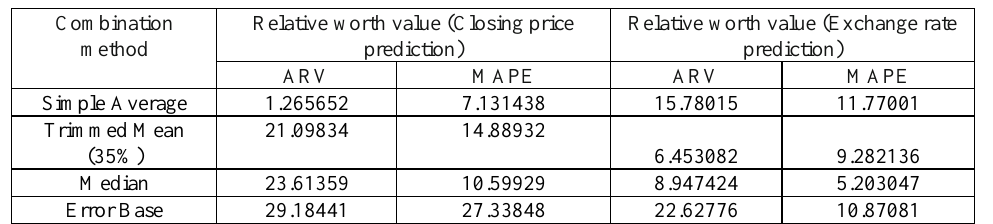
Table 7 . Relative worth values of combination